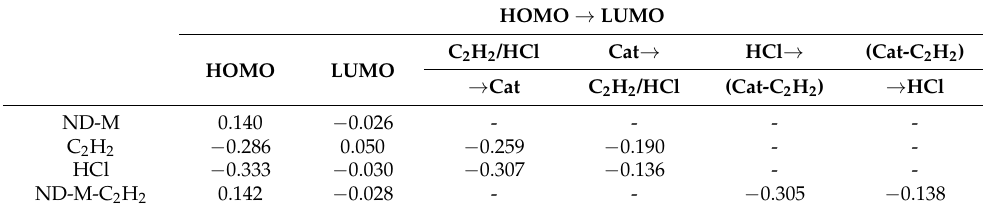
Figure 7. Frontier molecular orbitals of HOMO and LUMO for ND-M, C 2 H 2 , and HCl. Table 4. The energy detail values of the ND-M